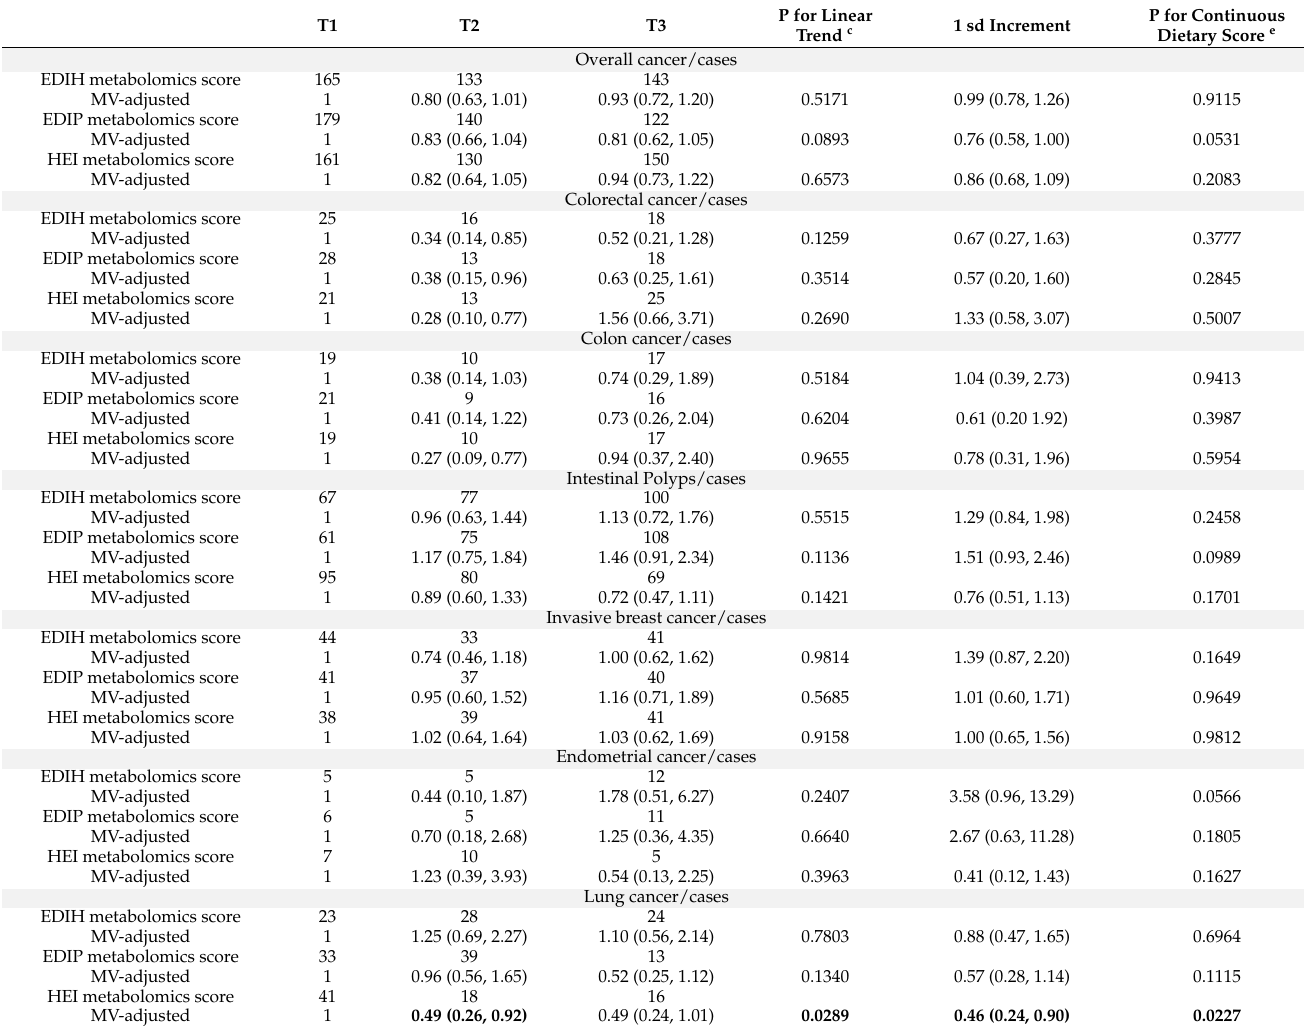
Table 3. Dietary pattern-related metabolomics signatures in relation to total cancer and site-specific cancer risks a,b,c,d,e,f